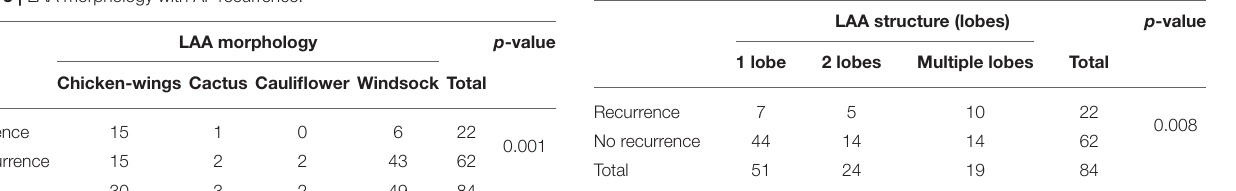
TABLE 4 | LAA structure (lobes) with AF recurrence.